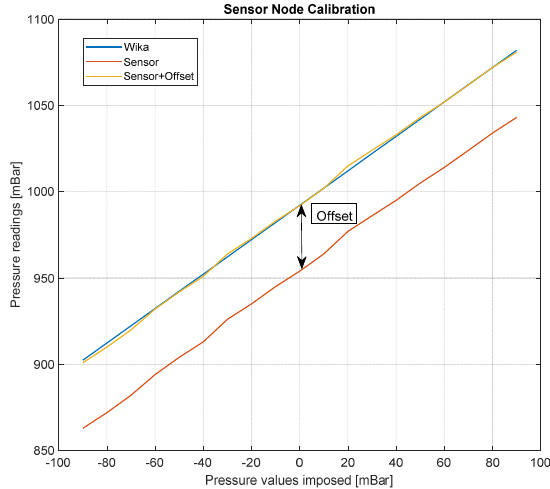
Figure 5. Example of calibration experimental data.